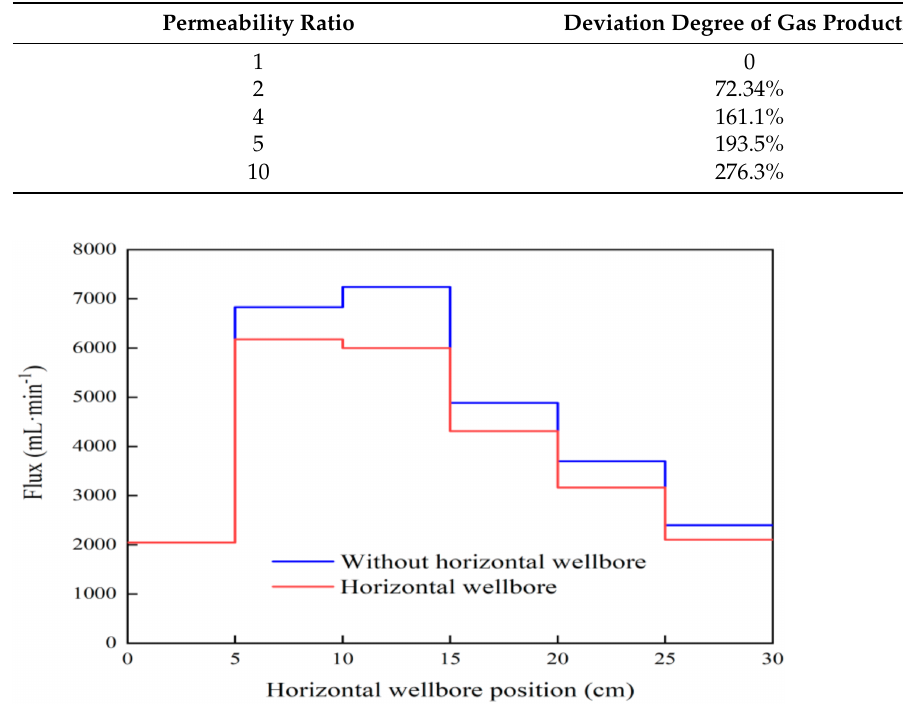
Figure 3. Gas production profile of cores with different permeabilities in parallel with a non- positive